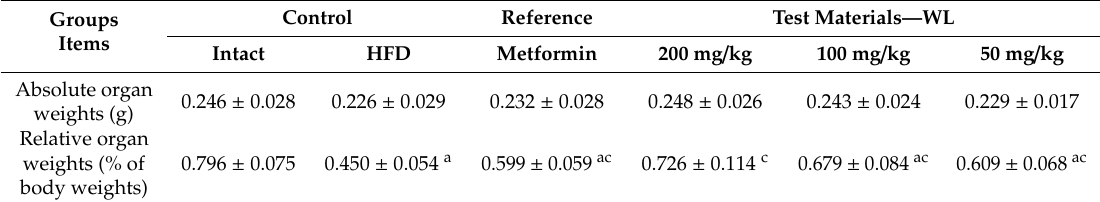
Table 6. Changes in absolute and relative pancreas weight in NFD or HFD supplied mice.